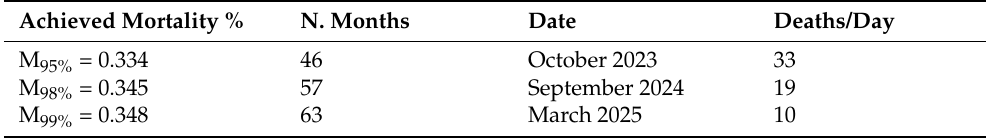
Table 4. Duration of the epidemic. Achieved Mortality % N.